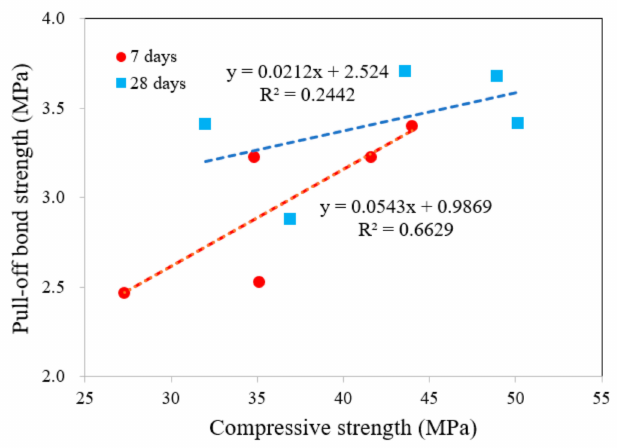
Figure 7. Relationships between averaged compressive and pull-o ff bond strengths at seven and 28 days.